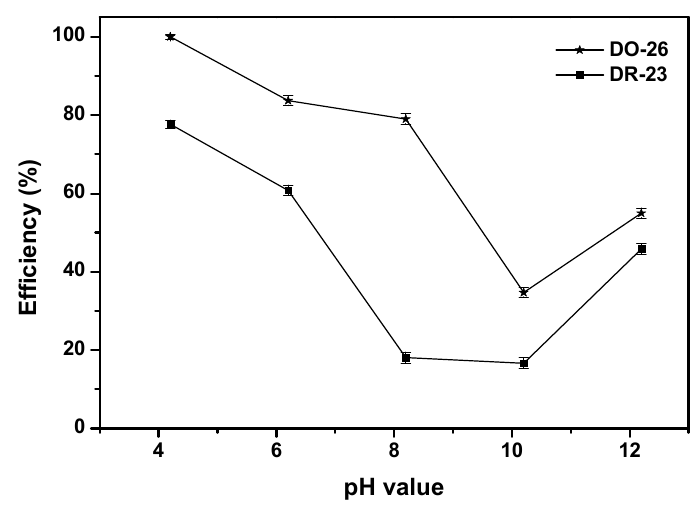
Figure 13. Effect of the initial pH value on the photocatalytic degradation efficiency of Direct Orange 26 or Direct Red 23.